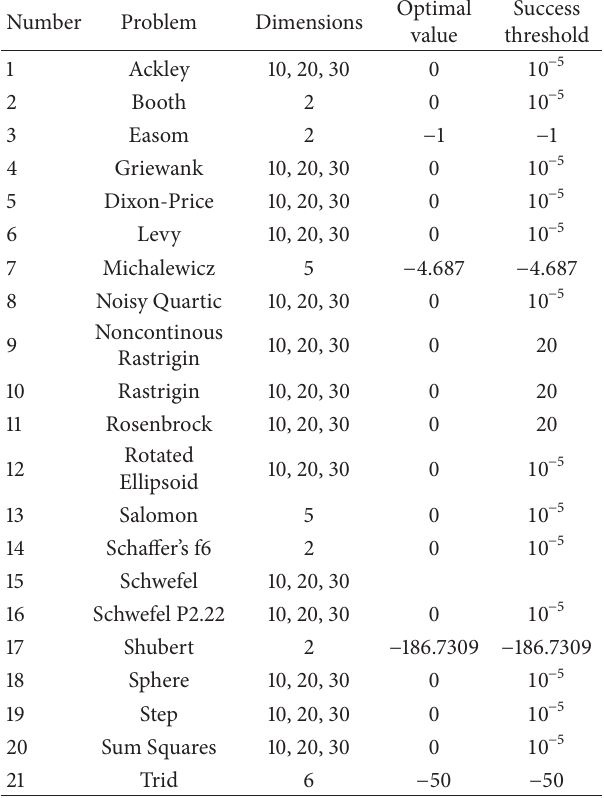
Table 2: Benchmark